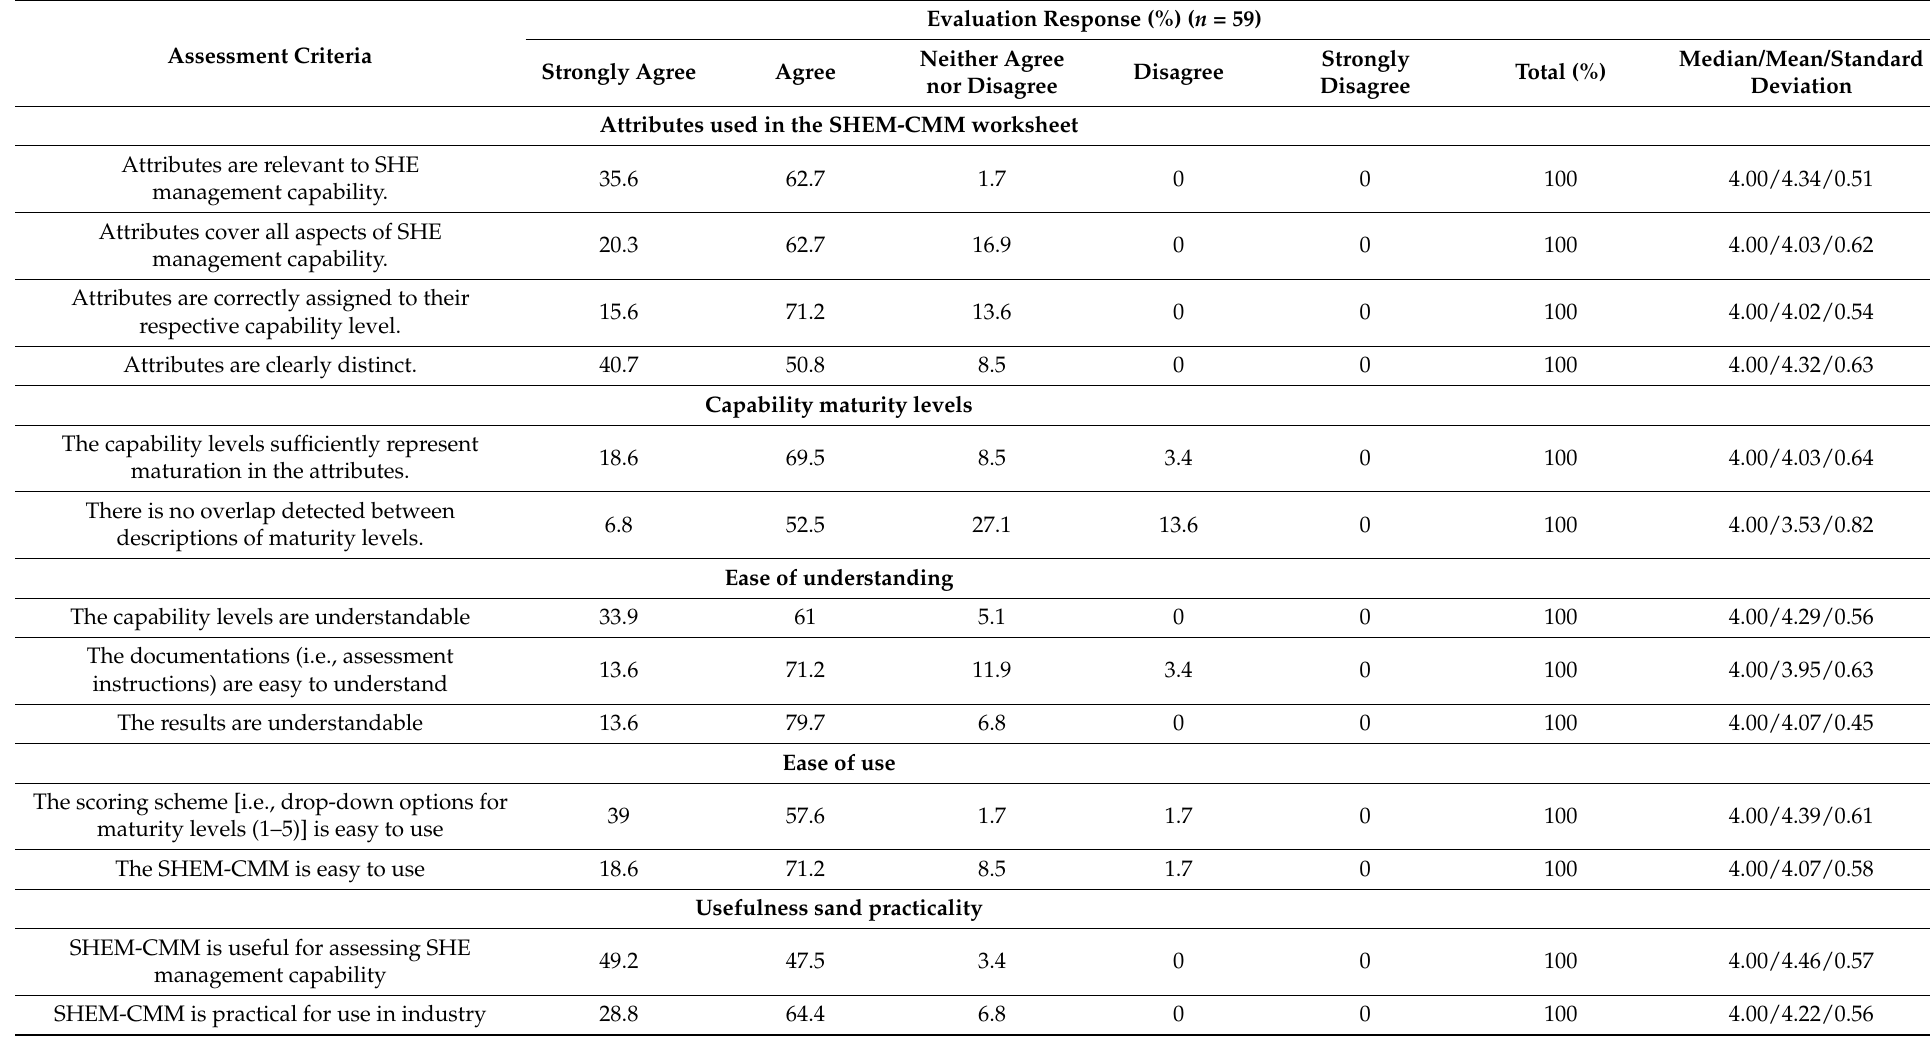
Table 4. Summary of responses feedback for maturity model